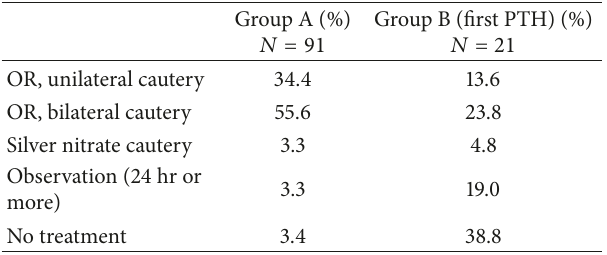
Table 3: Comparison of management of